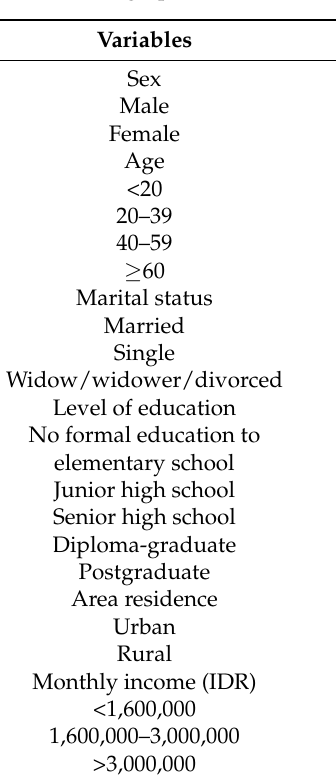
Table 1. Demographic characteristics of